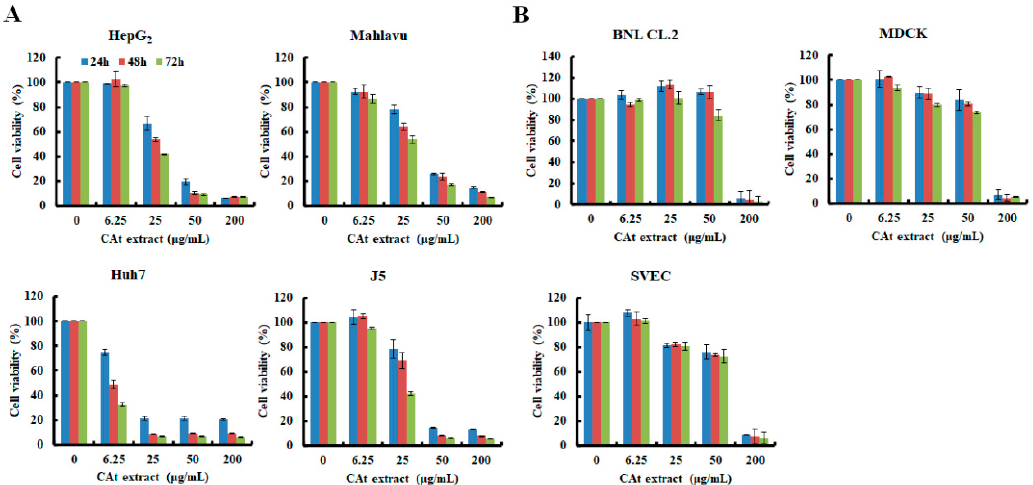
Figure 1. Effects of the Cedrus atlantica extract (CAt extract) extract on the growth inhibition of hepatocellular carcinoma (HCC) ( A ) and normal ( B ) cells. Cells were cultured in 96-well plates overnight and treated with or without CAt extract (0–200 µ g / mL) for 24, 48, and 72 h, and evaluated by an MTT assay. Data are expressed as the mean ± SD from two independent experiments. Table 1. Anti-proliferative inhibitory activities of the CAt extract in HCC and normal cells. Cell Line